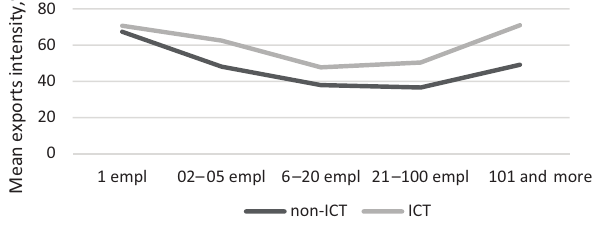
Figure 6. Export intensity by firm size and service type (ICT or non-ICT) for Estonian service traders 2018 (source: Statistics Estonia, 2022) Table 3. Export intensity by size and export orientation in Estonia, 2018 (source: Statistics Estonia, 2022) ICT Non-ICT Firm size (number of employees) N mean Std.Dev N mean